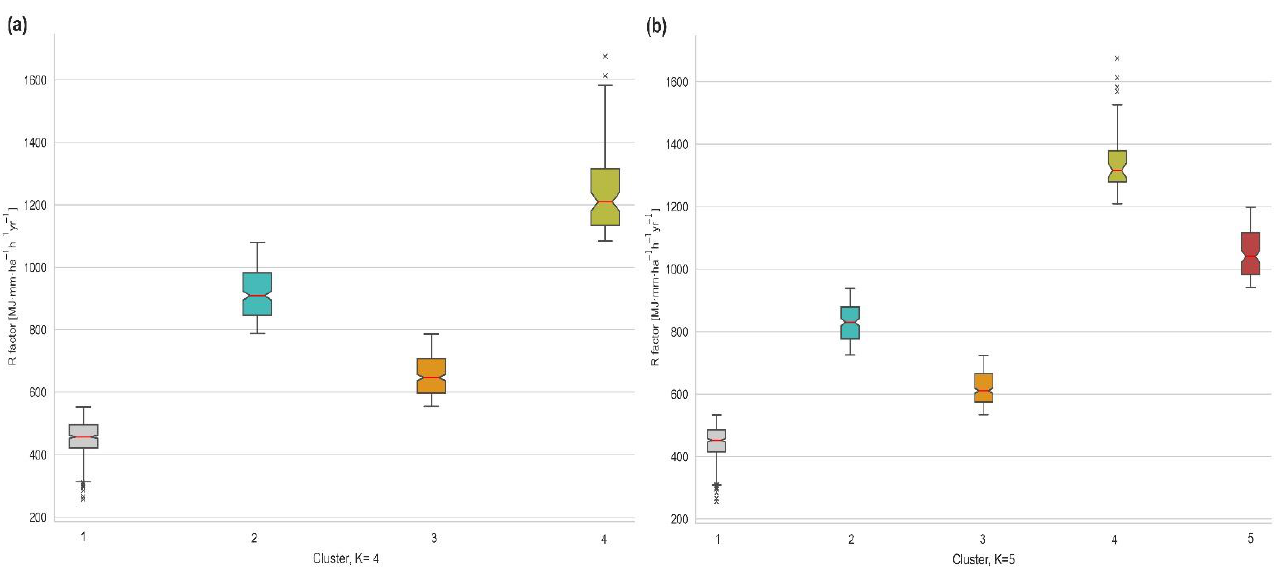
Figure 11. The difference in the R-factor distribution (RUSLE2 methodology) between the clusters for the total 30-year period if ( a ) K = 4 and ( b ) K = 5. the total 30-year period if ( a ) K = 4 and ( b ) K =